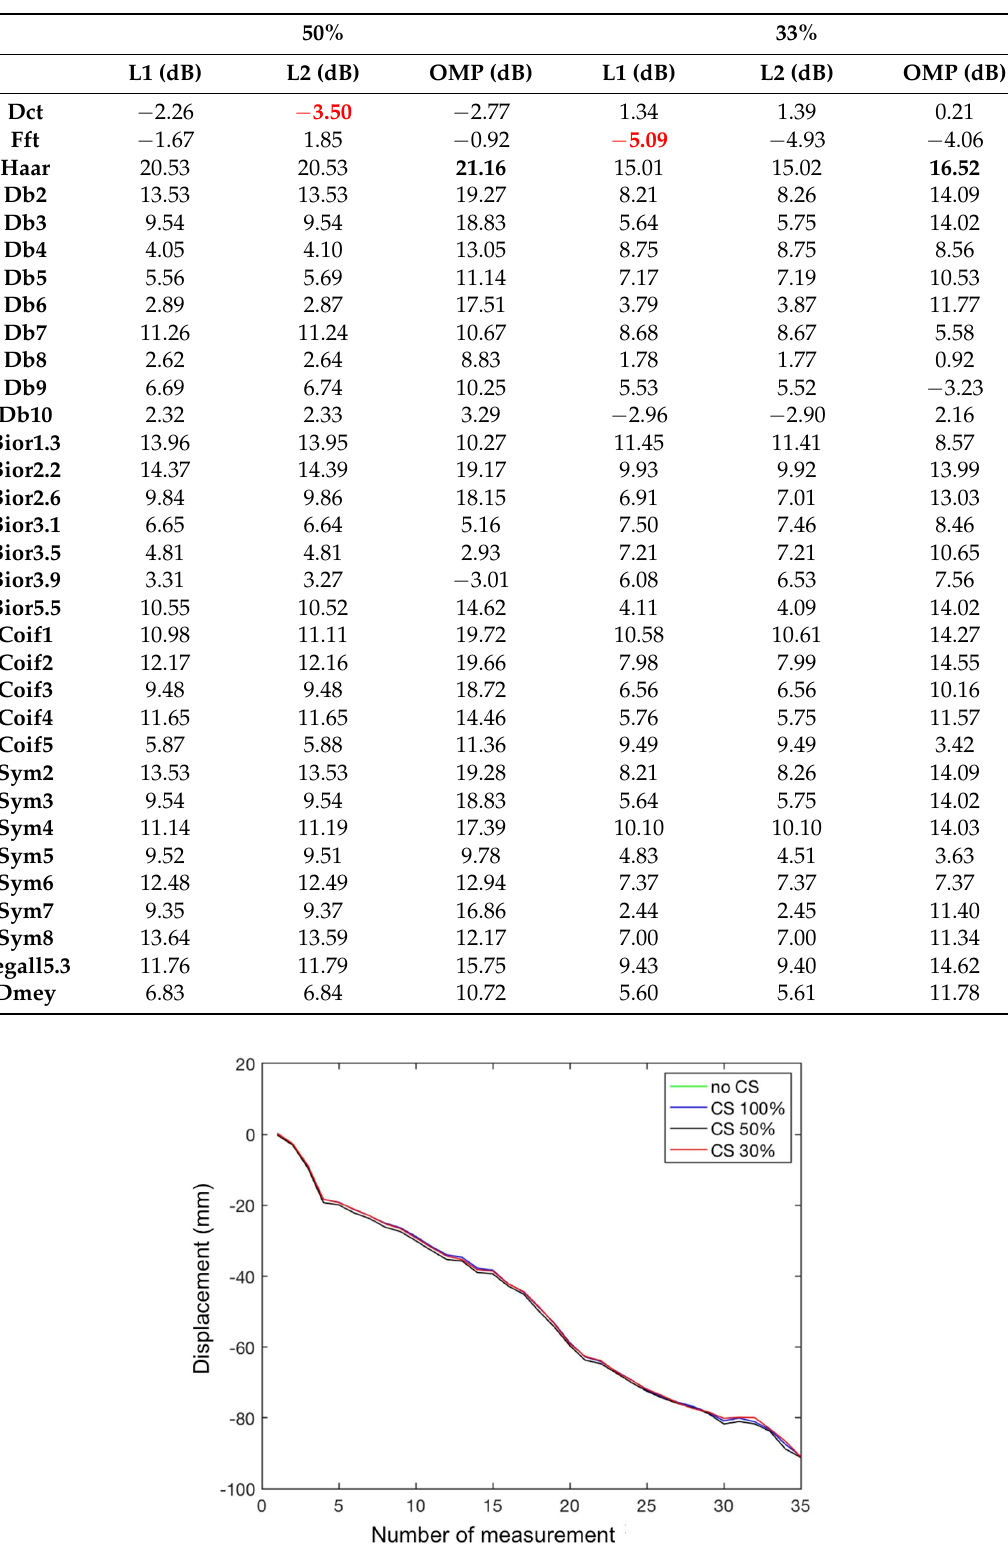
Figure 25. Cumulative measured displacement of a pixel inside the sliding body the glacier. Table 5 resumes the parameters of each measurement campaign and the highest value of PSNR obtained using 50% of data. Table 5. Parameters of each measurement campaign and the highest value of PSNR obtained using 50% of data